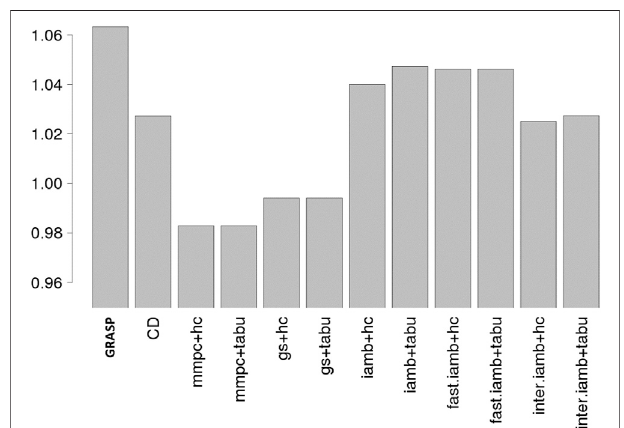
FIGURE 4 | BIC scores for the fl ow cytometry data, comparing 12 methods, and GRASP has the highest BIC score. The y-axis value is the ratio of the BIC score of the sampled network and the true network. It is possible that a sampled network has even higher BIC score than the true network, hence the value can be higher than 1.